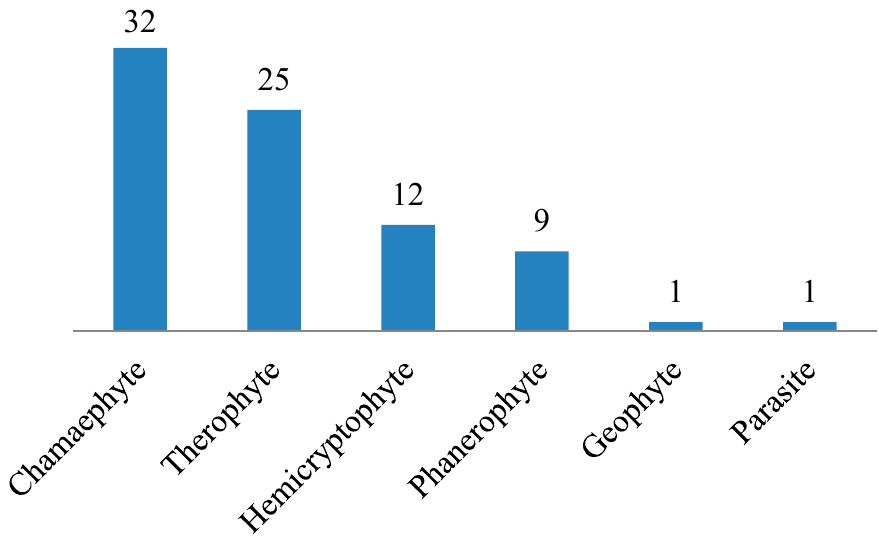
Figure 4. Life span of the species recorded in Wadi Hagul.